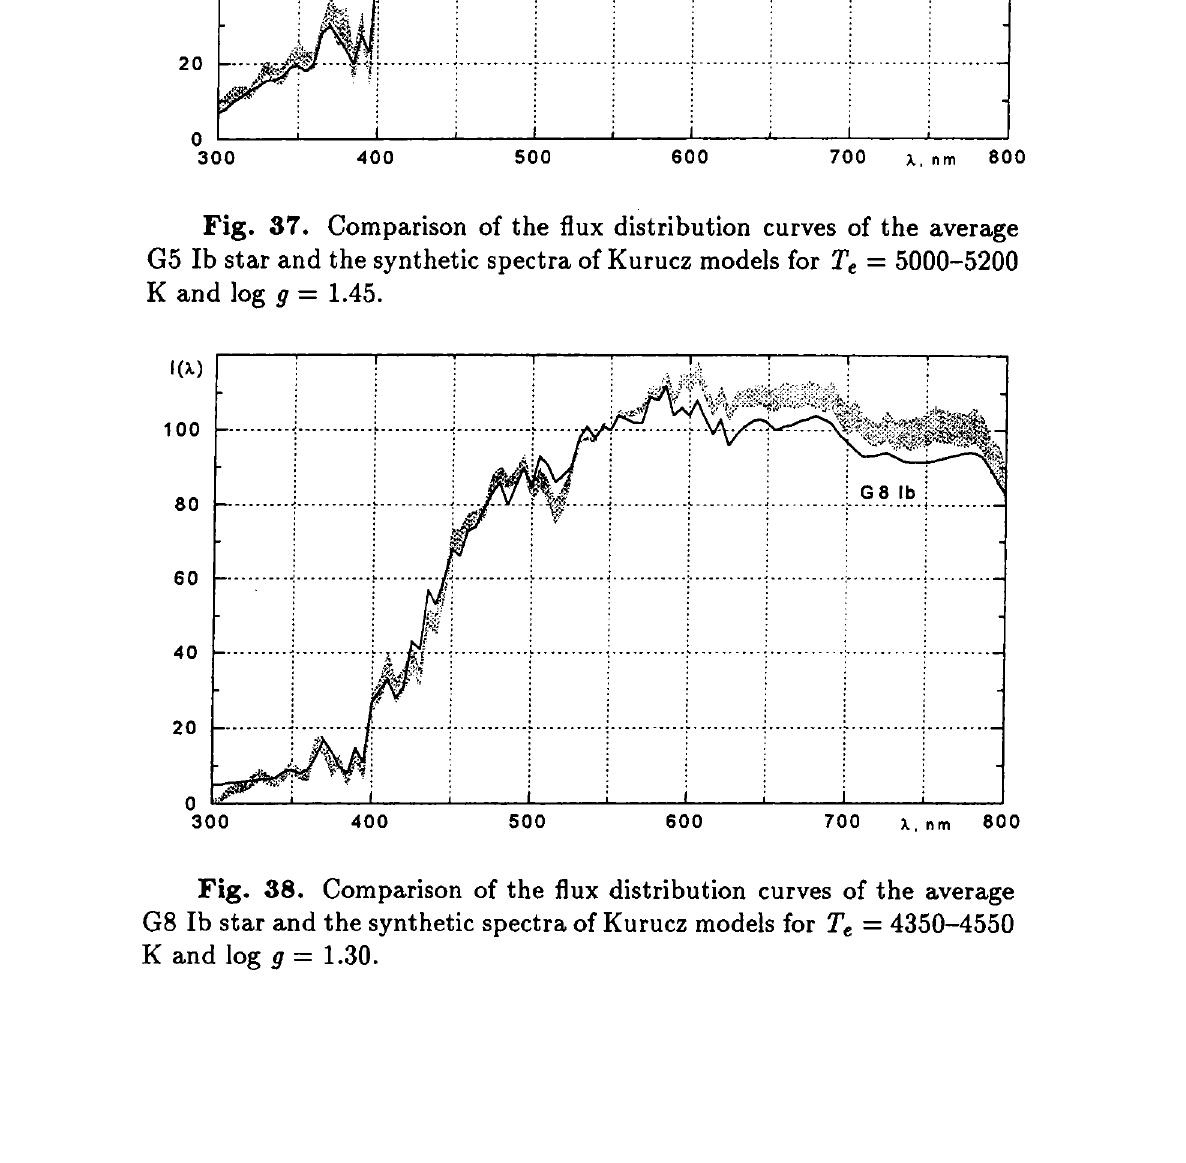
Fig. 38. Comparison of the flux distribution curves of the average G8 lb star and the synthetic spectra of Kurucz models for T K and log g =